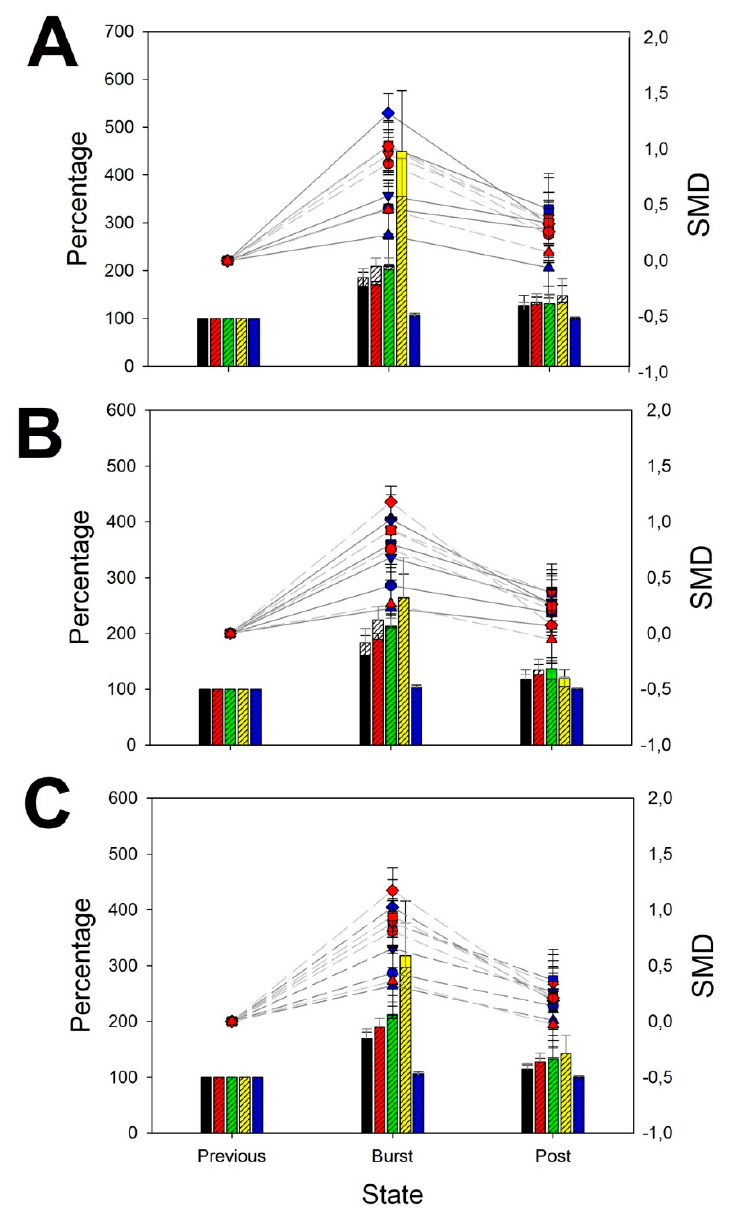
Figure 3. Normalized changes in power spectra and SMD during GS. ( A ) Frontal lobes; ( B ) parieto-occipital lobes and ( C ) temporal lobes. Bar graph (left y-axis): for every band and entropy, data from left (not-shaded color) and right hemisphere (shaded color) are superimposed ( δ = black, θ = red, α = green, β = yellow, Se = blue). Dot graph (right y-axis): SMD for every left (blue) and right hemisphere (red) for every band and entropy ( δ = circle, θ = down triangle, α = square, β = diamond, Se = up triangle).